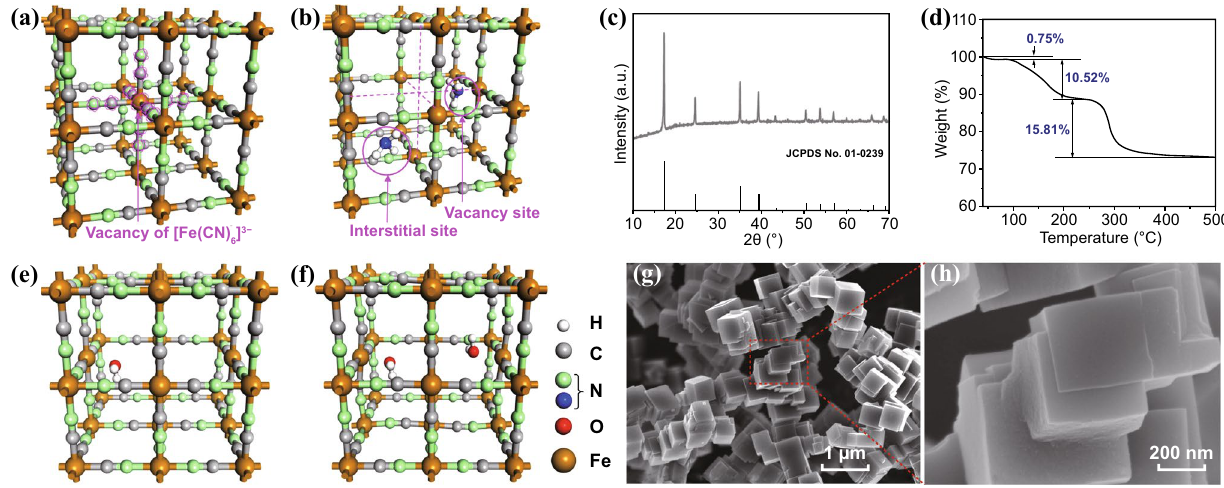
Fig. 1 a Atomic structure of BG, b absorbed ammonia molecule at two sites in BG lattice, c XRD patterns of BG powder, d TGA pattern of the prepared BG powder, e , f atomic structures of Fe[Fe(CN) 6 ] 0.75 · x H 2 O ( x = 1, 2), and g , h low- and high-resolution FESEM images of BG frame-